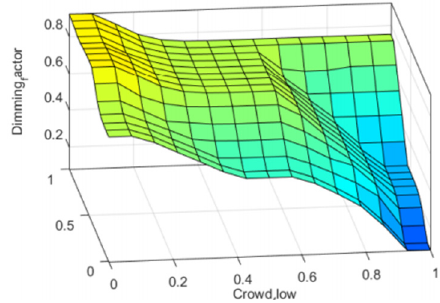
Figure 4. 3-D visualization of the inference rules.